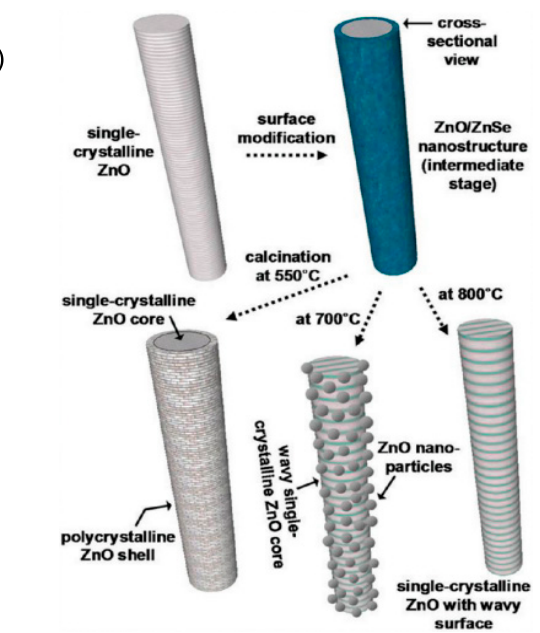
Figure 3. SEM images showing the effect of calcinations on ZnO particles in air for 3 h at ( a ) 550 °C; ( b ) 700 °C; or ( c ) 800 °C; ( d ) XRD patterns of the powders after calcination of the powders in air for 3 h; ( e ) Schematic illustration of the procedure for achieving surface texturing of a single-crystalline ZnO nanorod. Figure adapted from [38] with permission from copyright (2011), American Chemical Society (Washington, DC, USA).